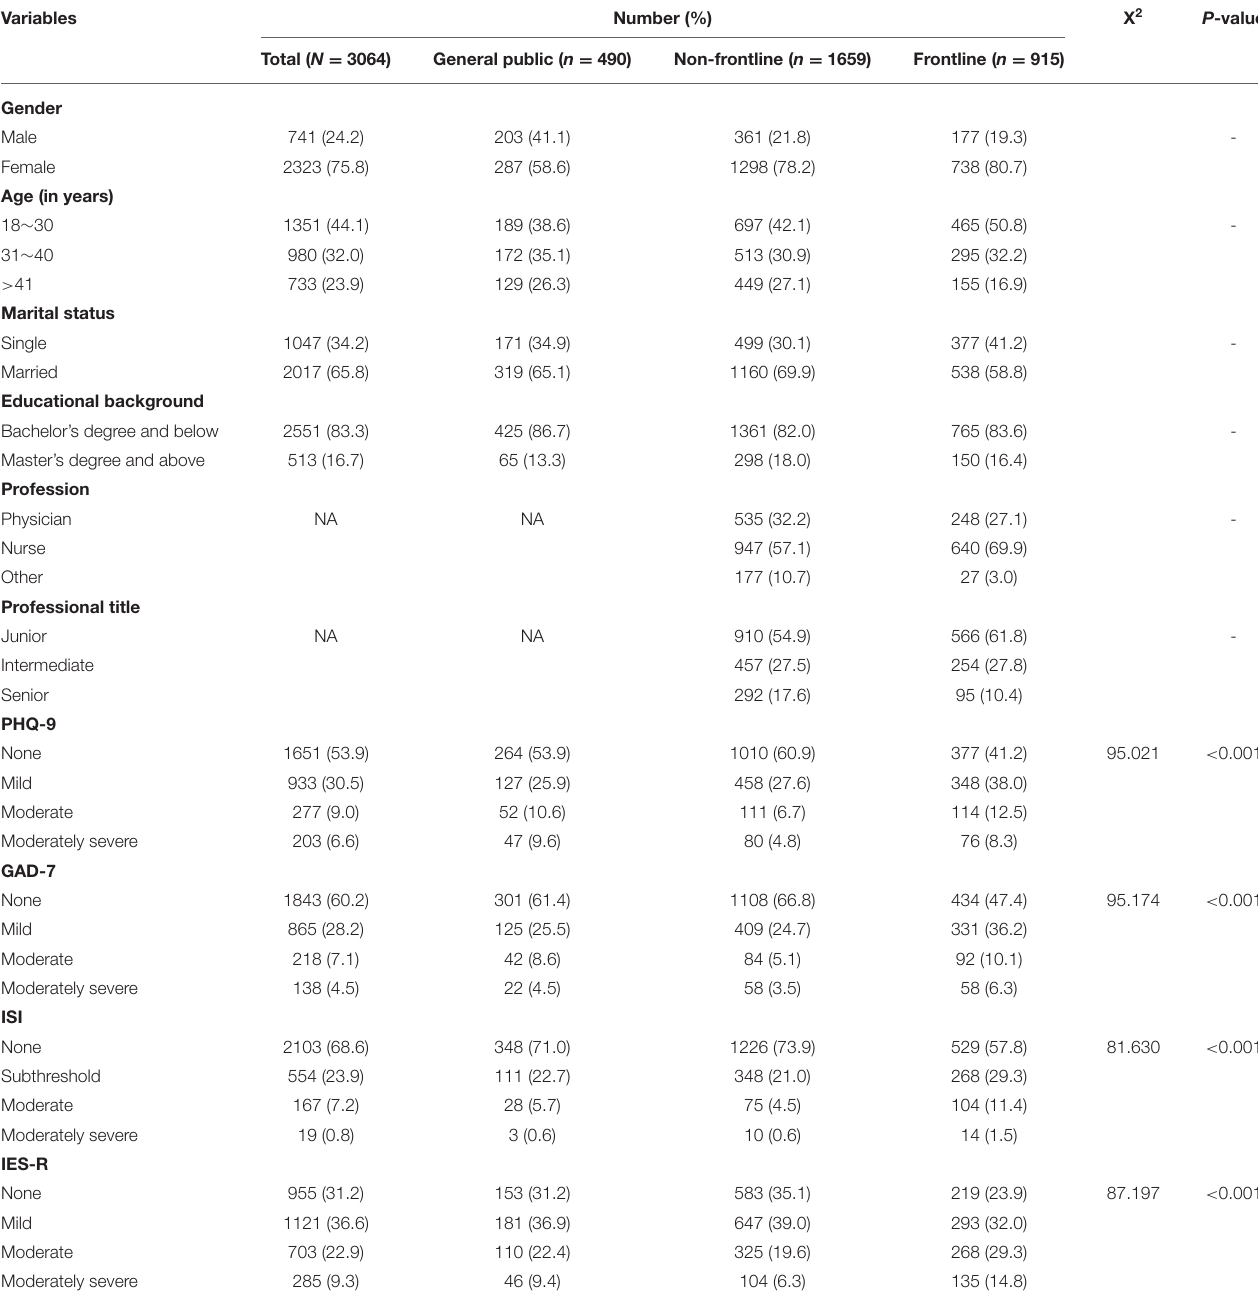
TABLE 1 | Socio-demographic characteristics of participants (general public, frontline, and non-frontline) ( N = 3,064).